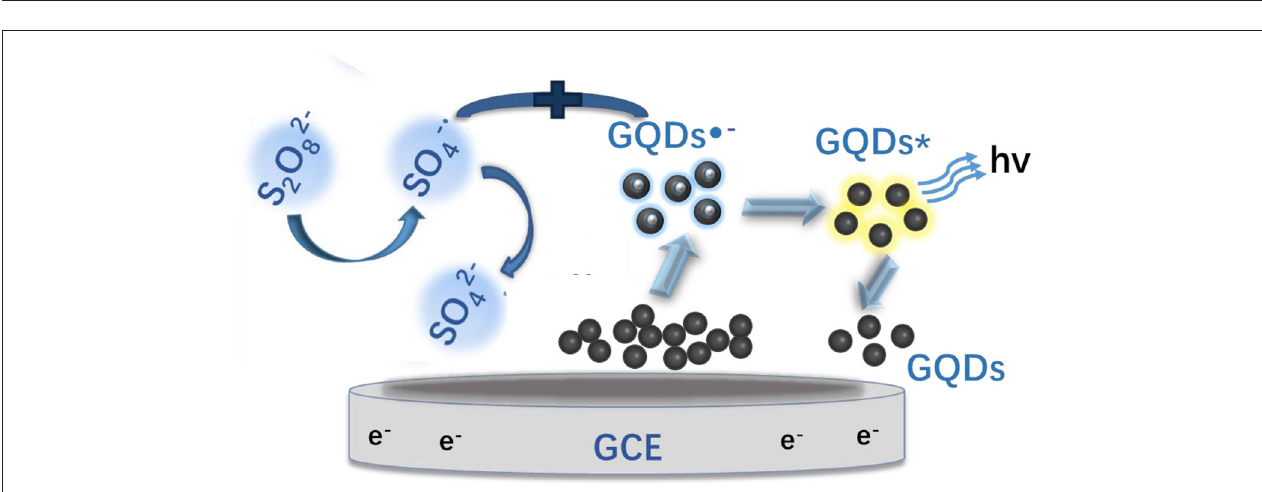
FIGURE 3 | Morphological characterization of GQDs using TEM and AFM. (A) TEM image with the inset showing the GQDs at 2 × magnification. (B) AFM image with the height profile of GQDs shown in the inset.